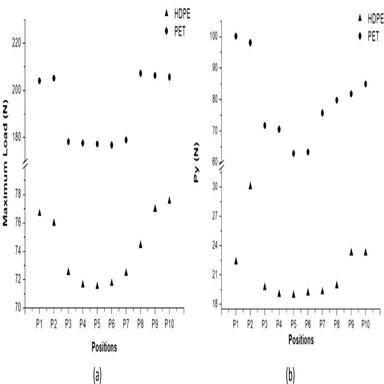
FIMEC test on irradiated HDPE and PET samples: values of the loads (a) and of the resistance parameters, Py (b) as a function of the indentation positions (from P1 to P10).